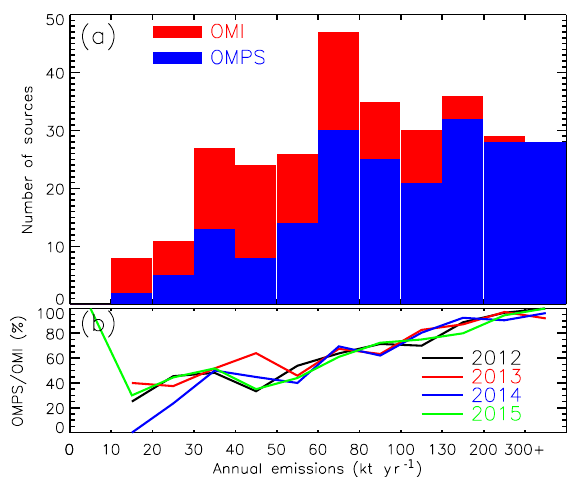
Figure 10. (a) Red (blue) bars: the number of SO 2 sources within different emission bins detected using OMI (OMPS) PCA retrievals for 2012. For a source to be counted as a successful detection, its es- timated annual emissions have to be at least twice the associated un- certainty; (b) the percentage of OMI-detected sources within each bin that is also detected by OMPS in different